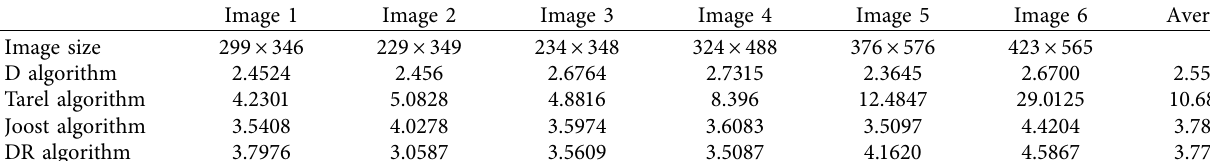
Table 6: Comparison of execution time of the proposed technique with existing techniques.